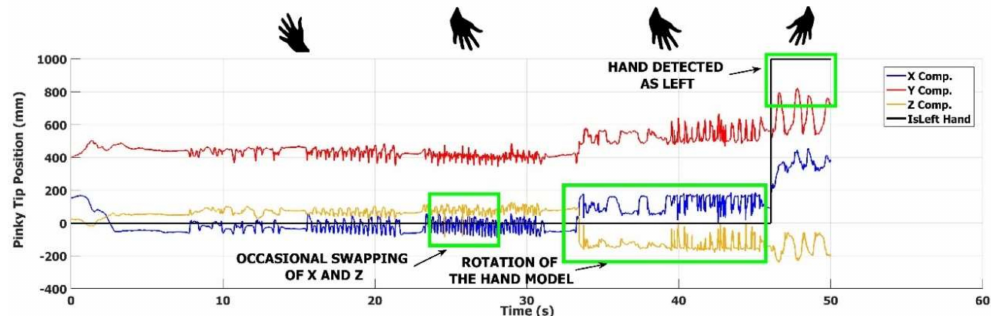
Figure 8. Example of Leap Motion ® tracker failures in the pinky tip tracking during a pronation-supination task. The figure shows the three components of the 3D position of the pinky finger during the execution of the movement. After a 20 s period, where the hand pose is correctly estimated, a period of 10 s follows where occasional swapping of the X and Z components occurs.